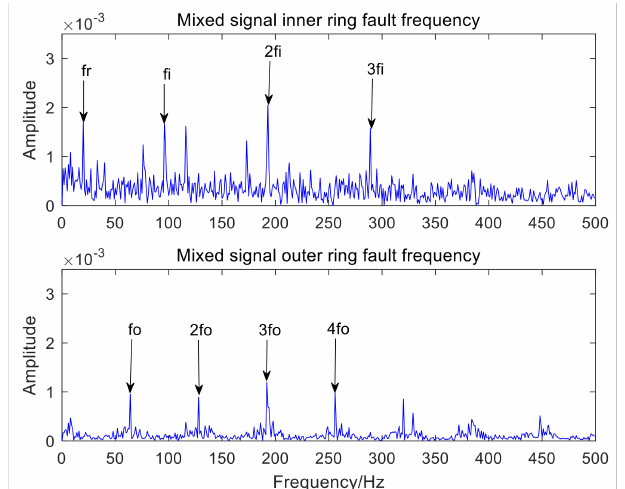
Figure 7. Envelope spectrum results using the AVMD-IMVO-MCKD.